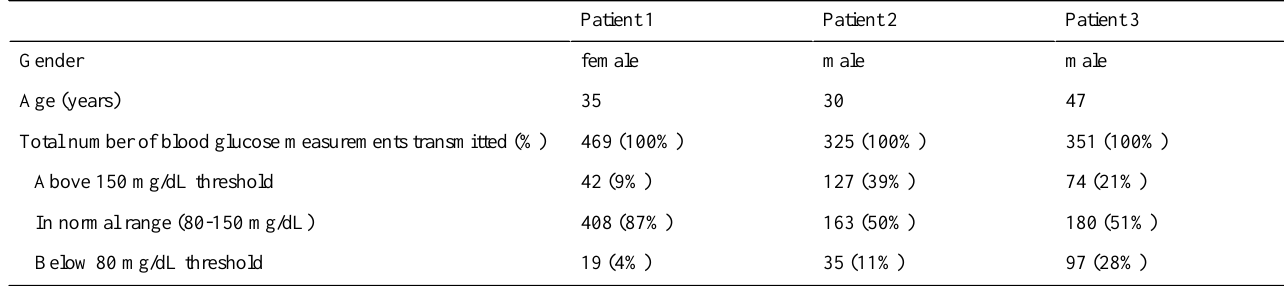
Table 4. Characteristics of three participants (corresponding 24-hour blood glucose profiles appear in Figure